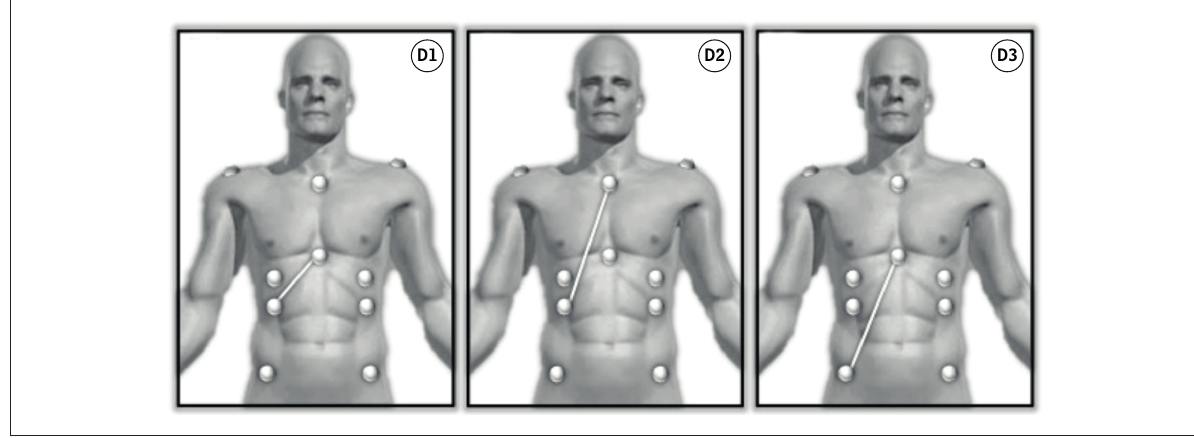
Note: D1 = xiphoid–last false rib on the right and left side; D2 = manubrium–last false rib on the right and left side; D3 = xiphoid–anterior superior iliac spine on the left and right